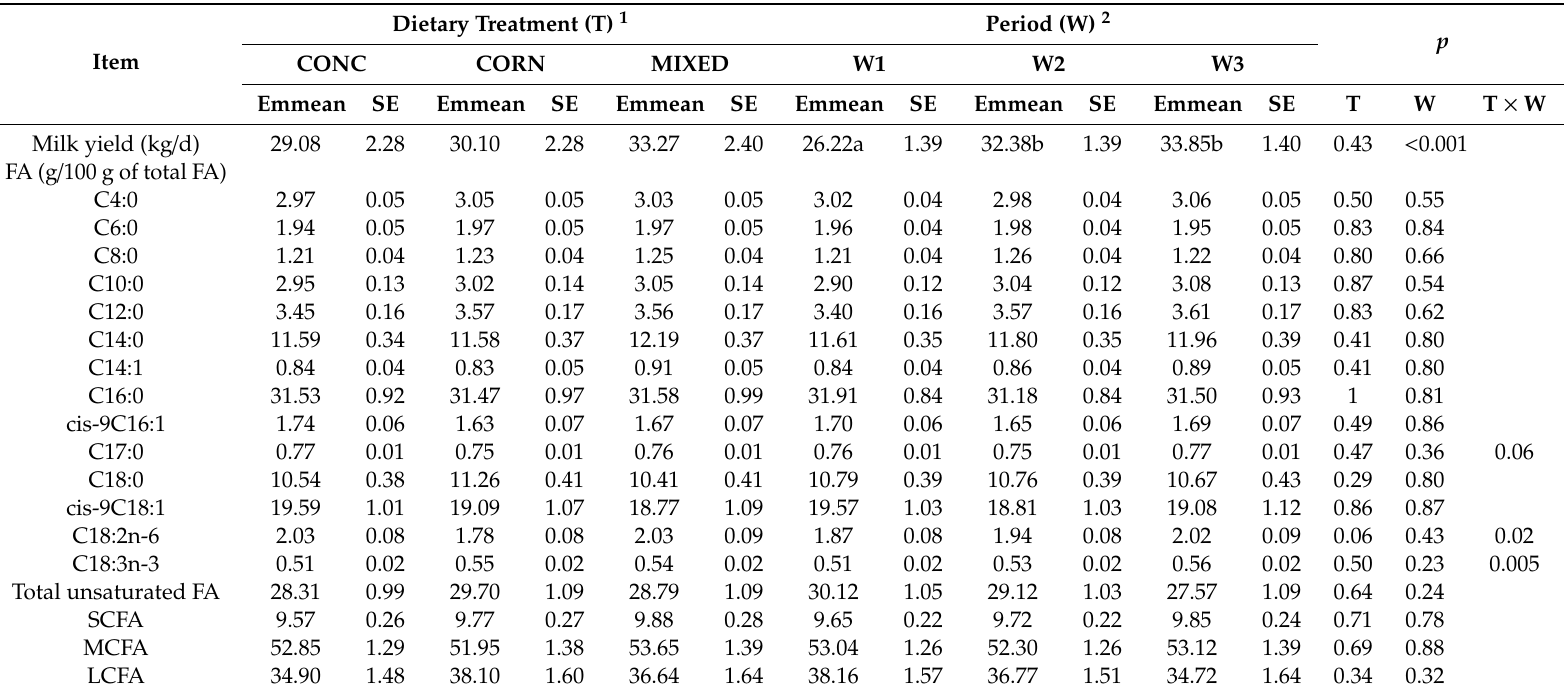
Table 3. E ff ects of the three dietary treatments given during the dry period on the milk yield and the milk fatty acids (FA)